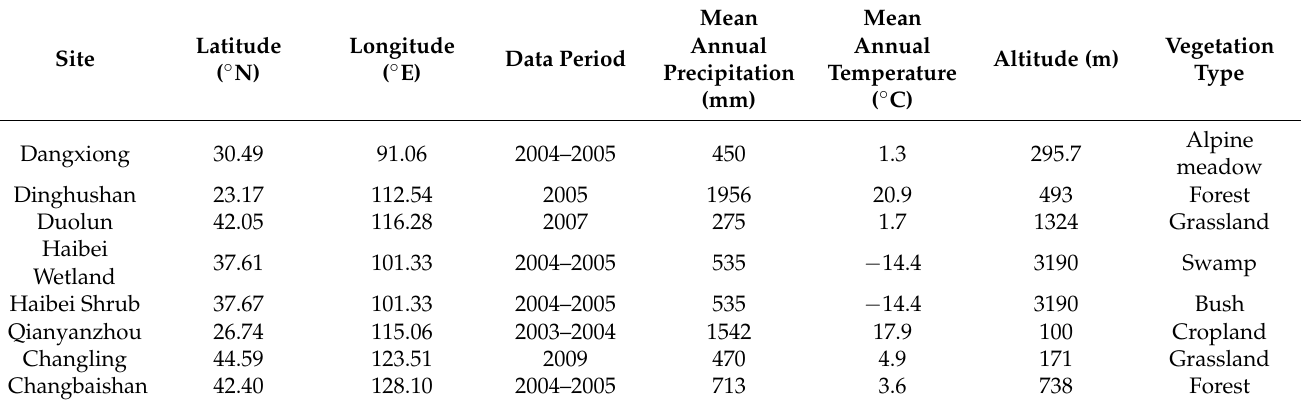
Table 2. Information about the geography and vegetation of the study